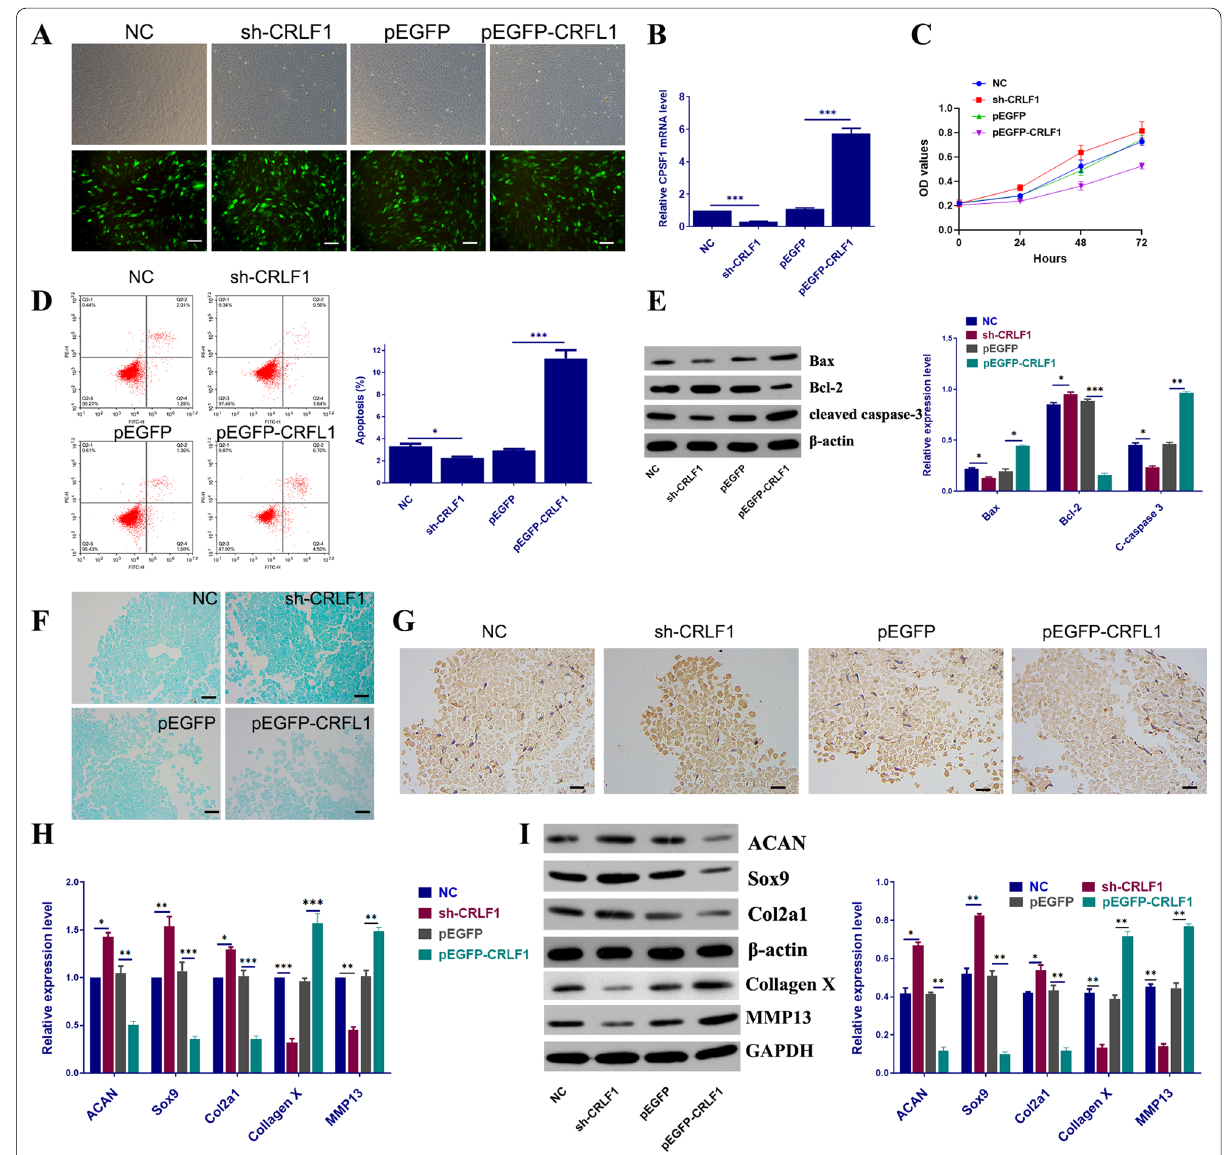
Fig. 3 Overexpression of CRLF1 inhibited BMSCs viability, induced apoptosis and suppressed cell differentiation. A Infection efficiency was determined by microscopic examination of the GFP-expressing cells (scale bar, 100 μm). B The CRLF1 expression in different transfected BMSCs. C The BMSCs viability of different transfected groups. D Flow cytometric analysis of BMSCs apoptosis of different transfected groups. E The expression of apoptosis-related proteins in different transfected groups. F The deposition of cartilage matrix proteoglycans was determined by Alcian blue staining (scale bar, 50 μm). G IHC results of Col2a1 expression in different transfected groups (scale bar, 50 μm). H qPCR showed the relative quantification of ACAN, Sox9, Col2a1, collagen X and MMP13 mRNA levels in each group. I Protein expressions of ACAN, Sox9, Col2a1, collagen X and MMP13were evaluated by western blot. Data are expressed as mean SEM and * P < 0.05, ** P < 0.01, *** P < ±